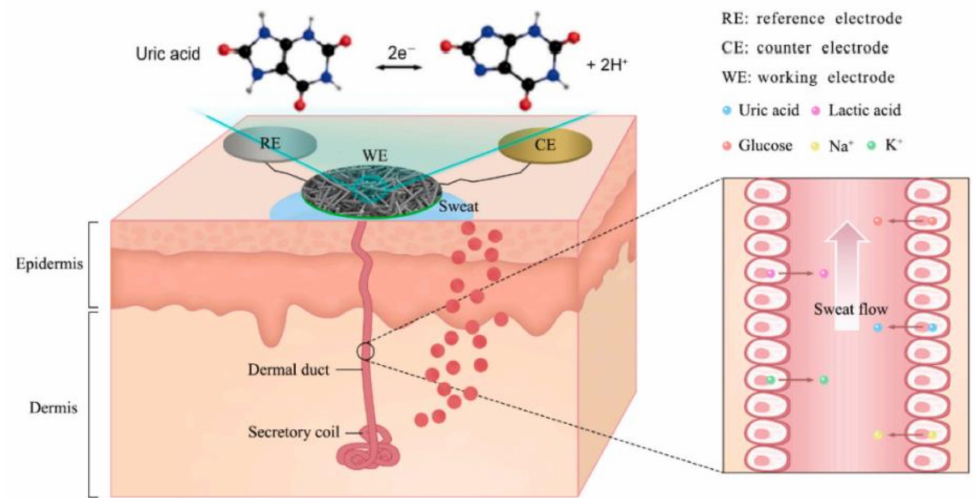
Figure 30. Illustrations showing the structure of the sweat glands, the release of biomarkers, and a wearable biosensor for detection of uric acid in sweat. (Reproduced from [563] with permission. Copyright 2021, Elsevier, Amsterdam, The